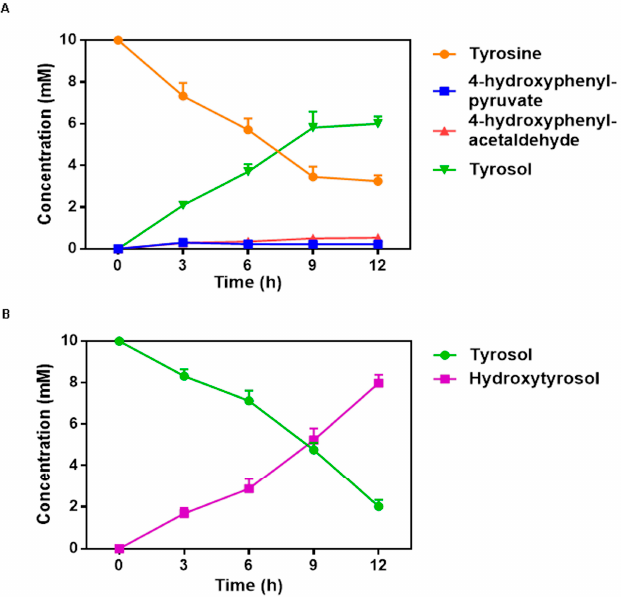
Figure 4. Fermentation time course of CCHT-1 and CCHT-2. ( A ) Time course of tyrosine, 4-hydroxyphenylpyruvate, 4-hydroxyphenylacetaldehyde and tyrosol during CCHT-1 fermentation. The orange closed circle, blue closed square, magenta closed triangle, and green closed triangle represents tyrosine, 4-hydroxyphenylpyruvate, 4-hydroxyphenylacetaldehyde, and tyrosol, respectively. ( B ) Time course of tyrosol and hydroxytyrosol during CCHT-2 fermentation. The green closed circle and purple closed square represent tyrosol and hydroxytyrosol, respectively. Data are expressed as the mean ± SD ( n =